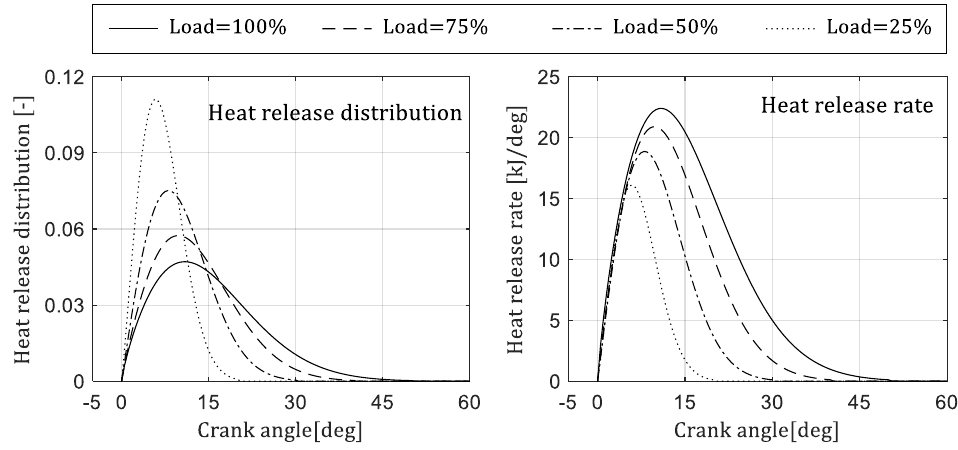
Figure 6. The heat release characteristics of the engine in gas fuel mode with the SL model.